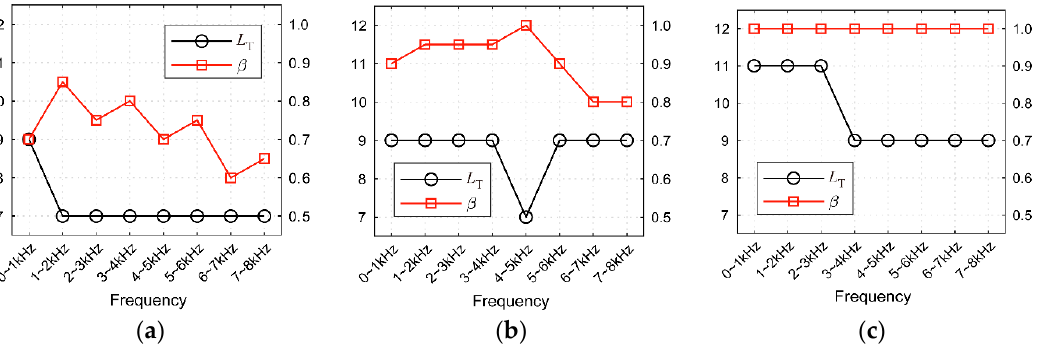
Figure 3. The optimal 𝐿 T and 𝛽 of female speech according to frequency intervals in ( a ) 0.37 s, ( b ) 0.69 s, and ( c ) 0.79 s of RT 60 with a 25-ms Hamming window, 10-ms hop length, and 512-point FFT.